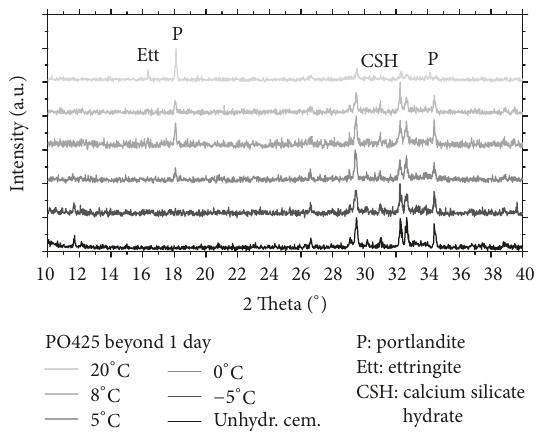
Figure 7: XRD result of OPC responded to curing temperature (1